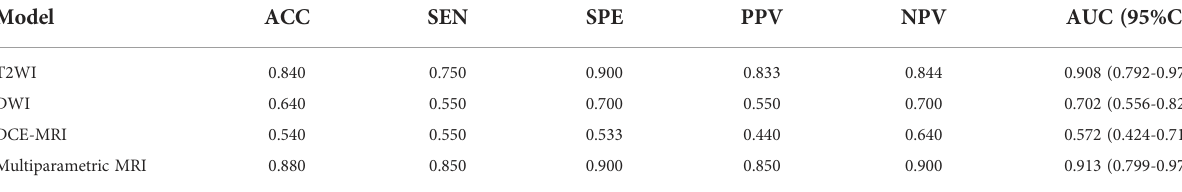
TABLE 3 Performance characteristics of the base and multiparametric MRI models. Model